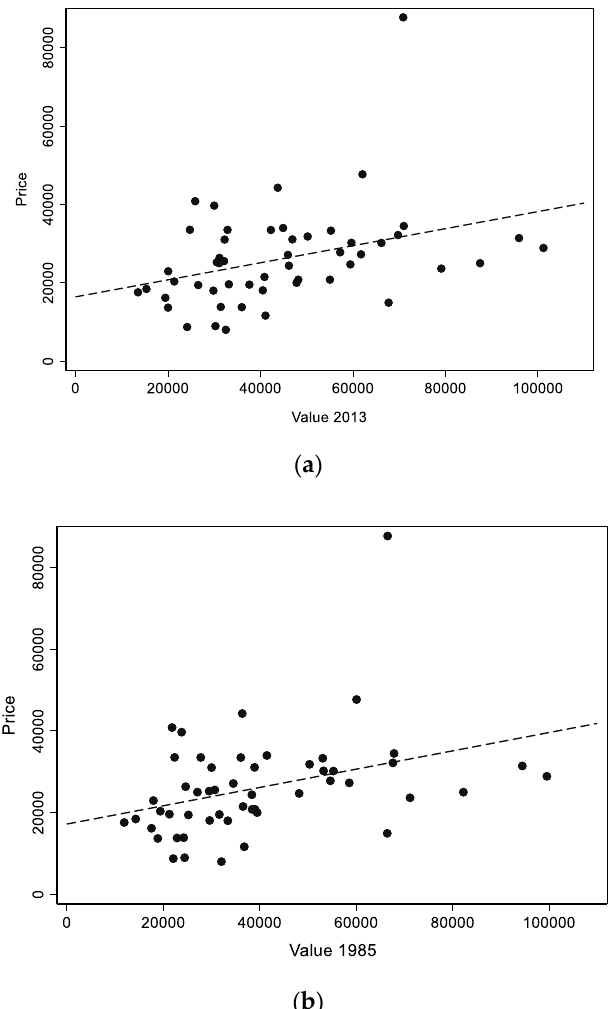
Figure 7. Correlation between sale prices and assessed values by valuation methodology: ( a ) upper panel results are based 2013 valuation tables; ( b ) lower panel results are based on 1985 valuation tables.